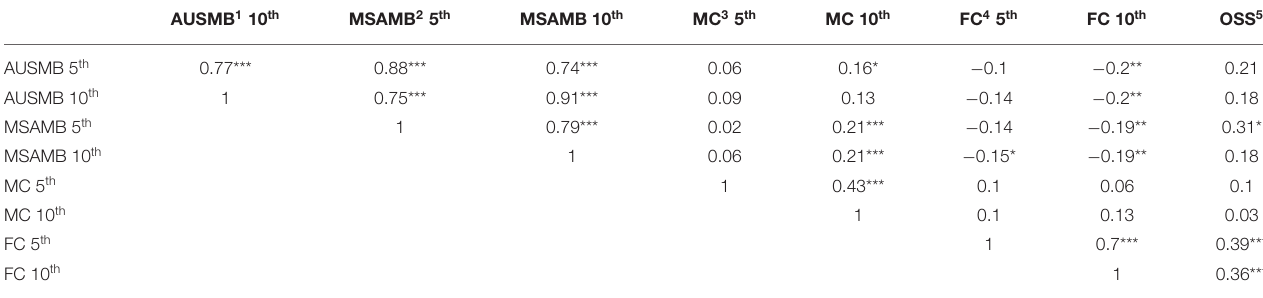
TABLE 3 | Correlation coefficients ( r ) among the assessment scores at the fifth rib and the tenth